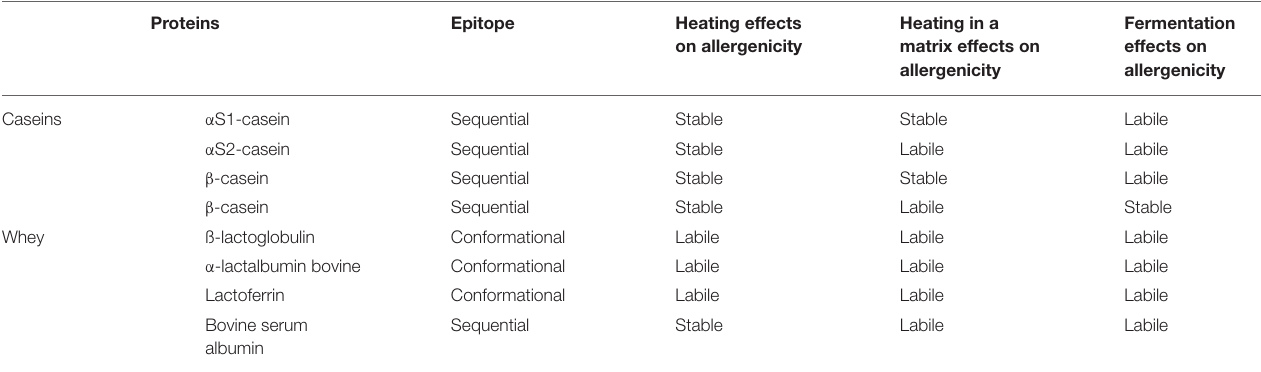
TABLE 2 | The main characteristics of cow’s milk proteins. Proteins Epitope Heating effects